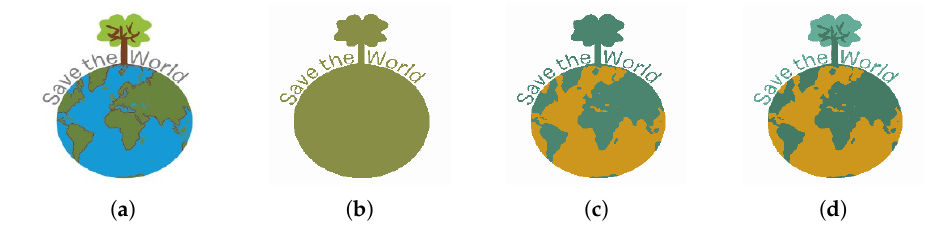
Figure 21. ( a ) Input image; ( b ) k = 2 clustering; ( c ) k = 3 clustering; ( d ) k = 4